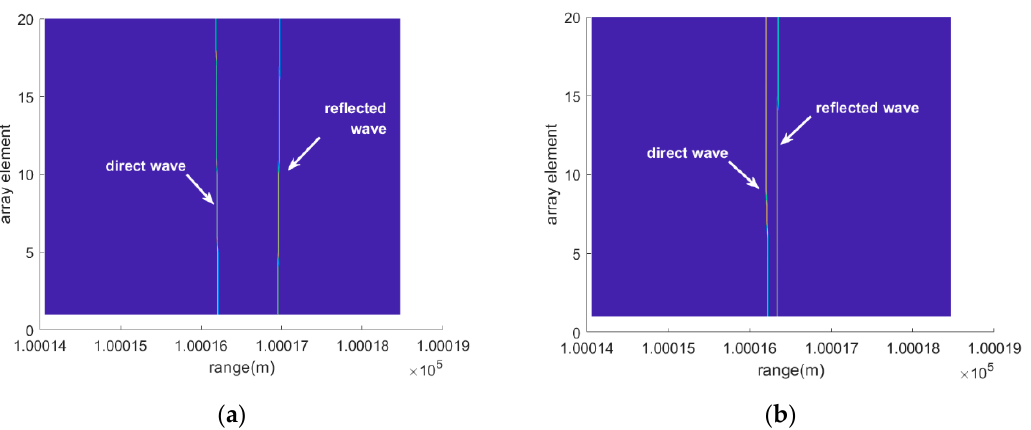
Figure 5. The RA graphs RELAX when the elevation angles are 6° and 1° in ( a ) and ( b ), respectively.